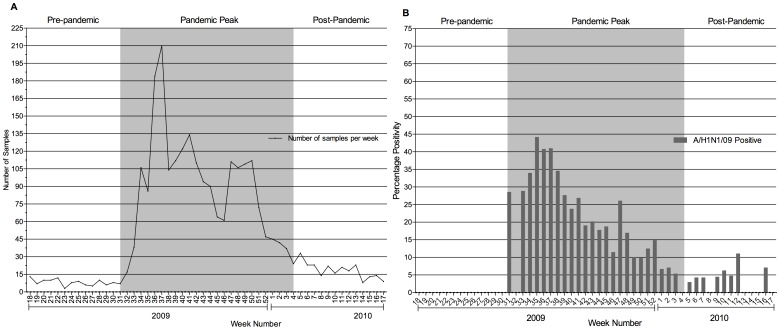
Influenza A Epidemic Curve (May 2009 to April 2010).The study period from May 2009 to April 2010 was divided into 3 periods a) pre-pandemic (13 weeks), b) peak-pandemic (26 weeks) and c) post-peak pandemic (13 weeks) periods. The figure represents A) the number of samples tested per week and B) week-wise distribution of positivity for A/H1N1/09. The X-axis represents the week of the year 2009 and 2010 and the Y-axis represents the percentage or number of samples. The peak positivity for pandemic influenza was during the 2009 week 36.